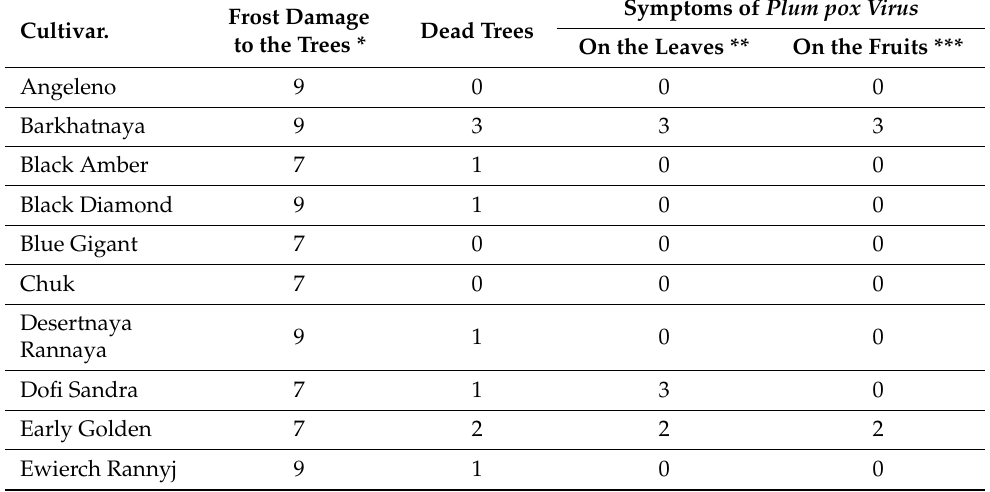
Table 1. Health status of 36 P. salicina cultivars that were grafted on ‘Wangenheim Prune’ seedlings. Symptoms of Plum pox Virus Frost Damage Cultivar. Dead Trees to the Trees * On the Leaves ** On the Fruits